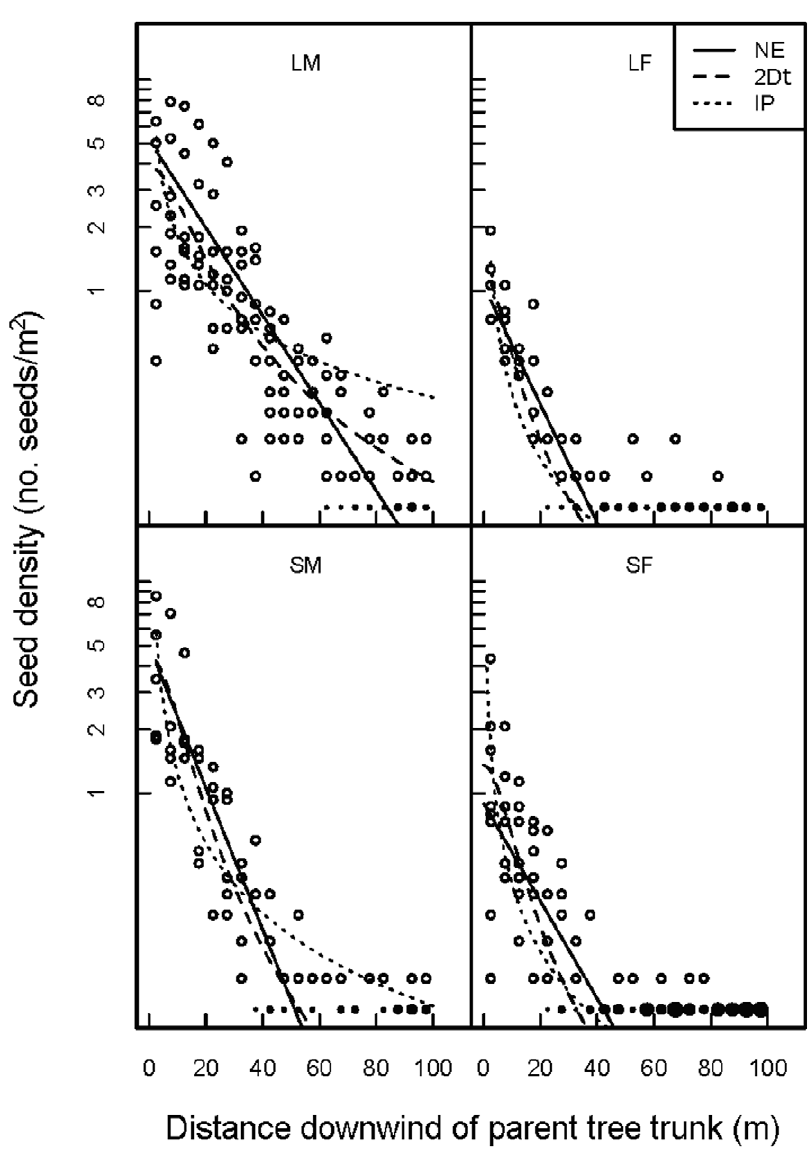
Figure 2. Seed densities of mahogany ( Swieteniamacrophylla ) dispersal downwind from 25 parents in Para´, Brazil. The isolated parent trees were assigned to one of four groups based on diam and fruit crop size: SF = small–few, SM = small–many, LF = large–few, LM = large–many. Open circles show overall seed densities in 1-m 6 5-m quadrats along W, NW, and SW 100-m long transects; filled circles represent zero seed densities, with symbol size proportional to frequency, observed along these same transects. Curves shown are fitted functions: NE = negative exponential; 2Dt = Student- t distribution; and IP = inverse power (see Table 1 ). Note the logarithmic scale on y-axis. doi:10.1371/journal.pone.0017488.g002 across 10 years ( Fig. 1 , Supporting Information S1 ). In a given year only a few trees will have large seed crops, and some skip reproduction altogether. Large successive crops of fruit on the same tree are rare, a pattern likely for many other tropical trees in other forests as well [34,35,51–55]. In an African rain forest, fecundity was poorly explained by individual tree traits like crown area, height and diameter for nine species including three that were wind-dispersed [22]. Elsewhere, diameter was a significant yet imprecise ( r 2 = 0.26) predictor of tree-level fecundity in only 8 of 14 tree species in a Malaysian rain forest [56]. Hence the generality of using a positive scaling of diameter with fecundity deserves greater scrutiny when modeling dispersal within a species if tree size-fecundity relationships tend to flatten beyond a reproductive size-threshold [51].